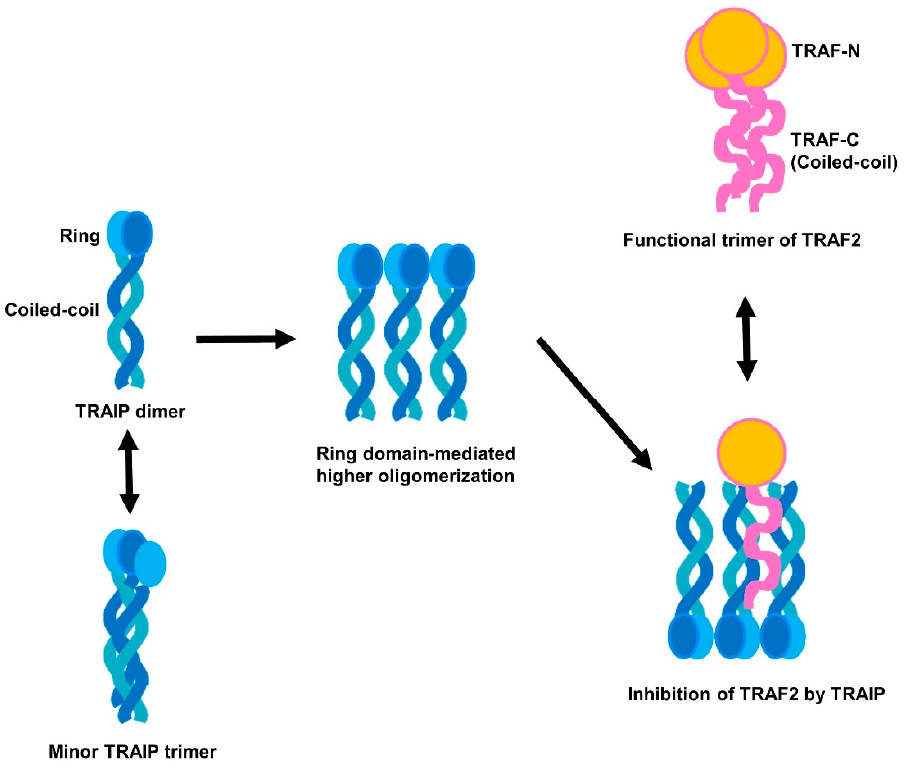
Figure 6. Potential inhibitory mechanism of TRAIP against TRAF2.